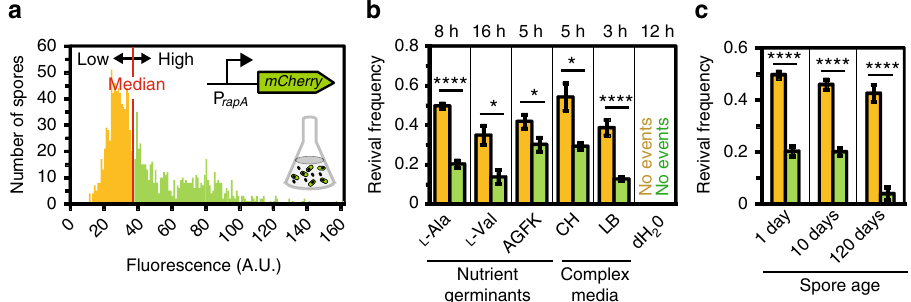
Fig. 6 Sporulation timing controls nutrient-induced spore revival. a Histogram of fl uorescence values obtained from spores that carry the P rapA - mCherry reporter (BIB1126) and were generated in a shaken SM culture. The median is marked in red and was used to group early and late spores. b Revival frequencies of early and late spores in response to the indicated nutrients measured at the designated times. c Revival frequencies of early and late spores that were kept in buffered saline for different times and then stimulated with L -alanine. Day 1 denotes the day of spore collection. Strain: BIB1126. Data: mean ± SEM, n ≥ 5 movies ( n s ≥ 900), unpaired t test: * P ≤ 0.05, ** P ≤ 0.01, *** P ≤ 0.001, **** P ≤